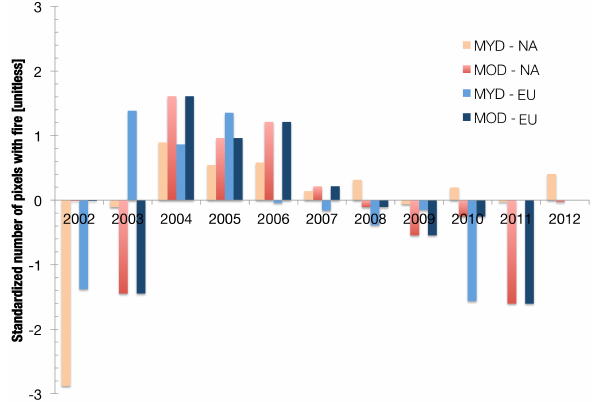
Figure 7. Standardized cumulative number of fires (April through Figure 7 to August) detected over North America (NA) and Eurasia (EU) by the MOD14CMH and MYD14CMH GCM climatology products between 2002 and